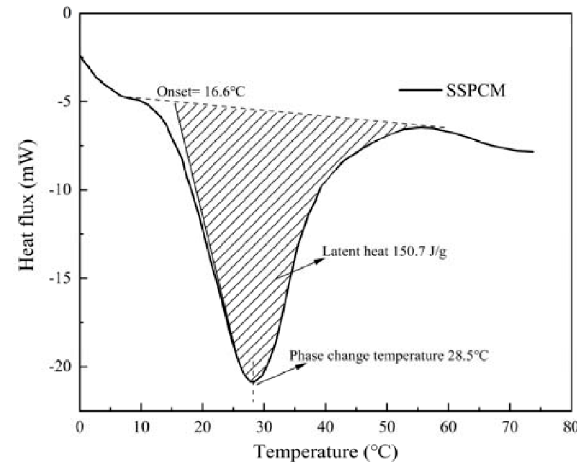
Figure 4. The DSC curve of the SSPCM.